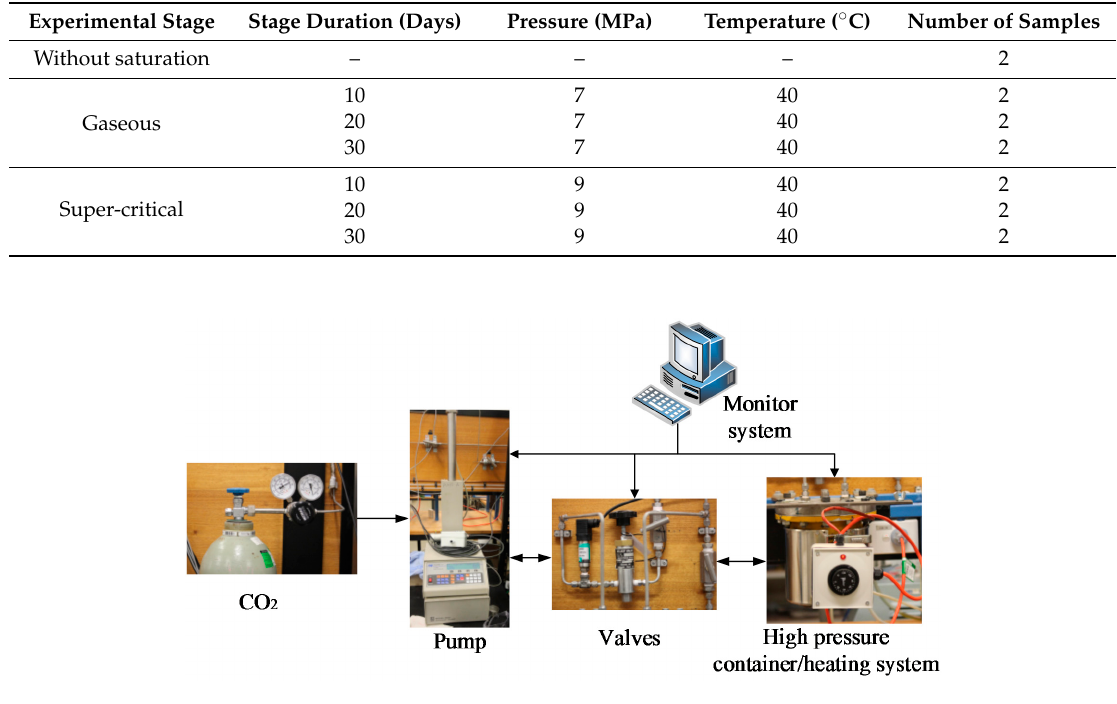
Figure 2. High-pressure adsorbing system.